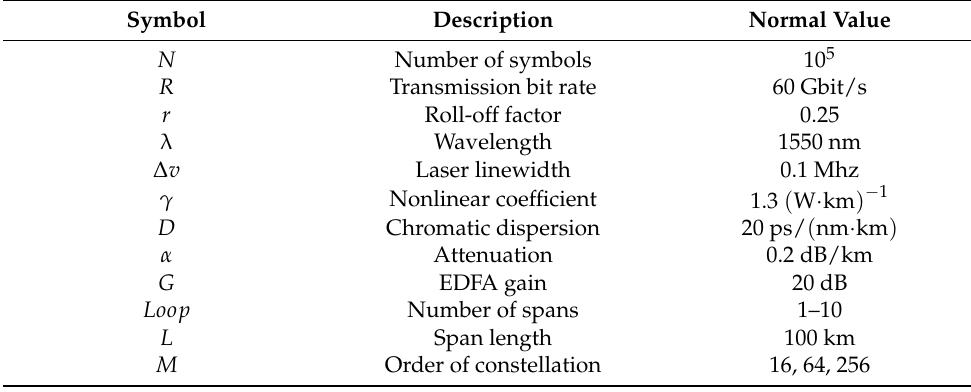
Figure 3. Simulation setup of a single carrier system for the data center interconnection network. Table 1. The parameters of simulation system.